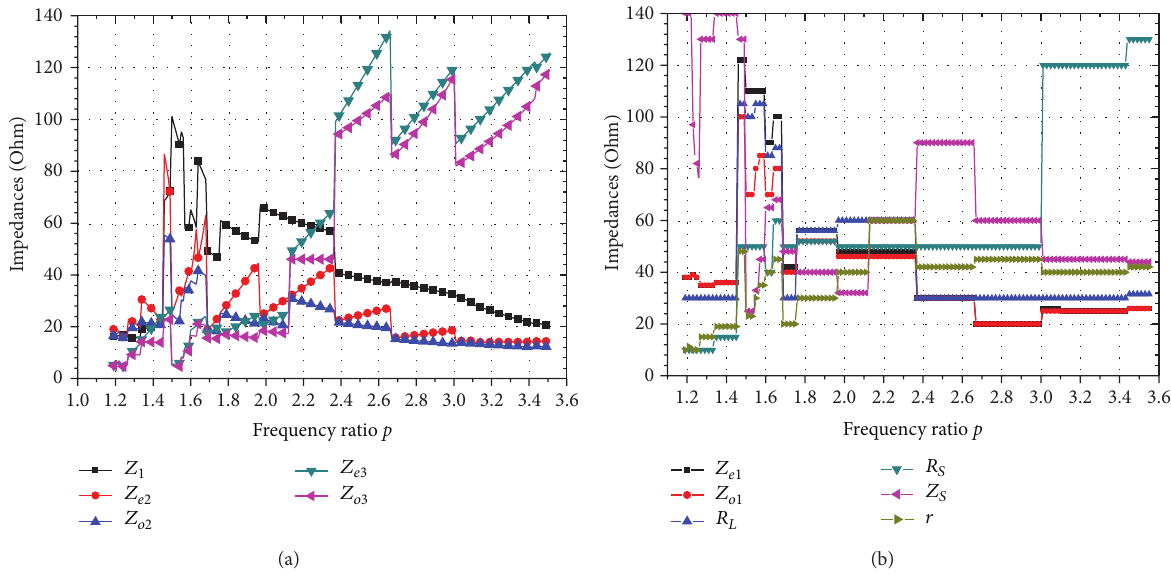
Figure 5: Typical design parameters of the proposed dual-band power divider with arbitrary 𝑅 𝑆 and 𝑅 𝐿 values. (a) Values of 5 variables: 𝑍 1 , 𝑍 , 𝑍 𝑍 𝑍 𝑒2 , 𝑜2 𝑒3 , and 𝑜3 . (b) Values of 6 free variables: